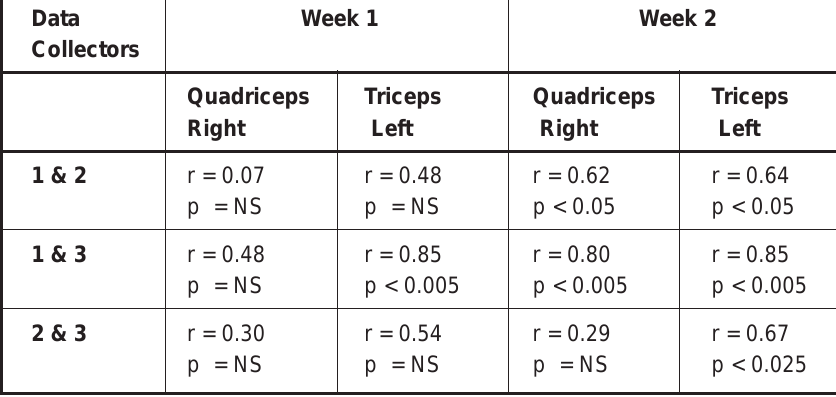
Right Left Right Left